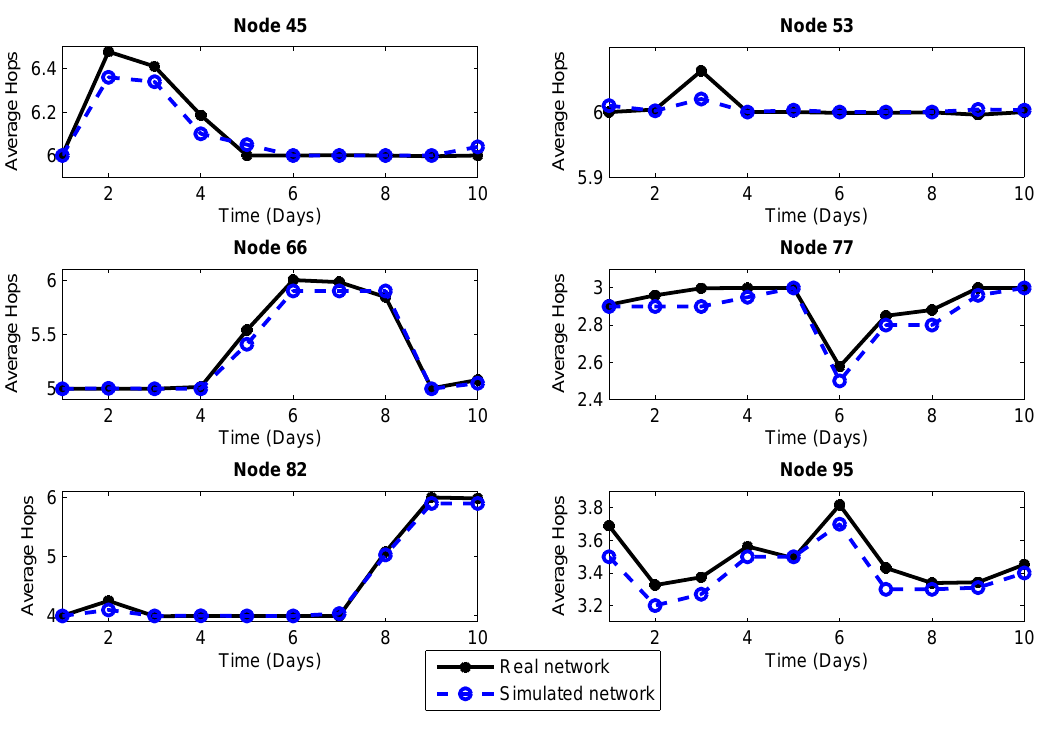
Figure 7. Average hops per day in relay